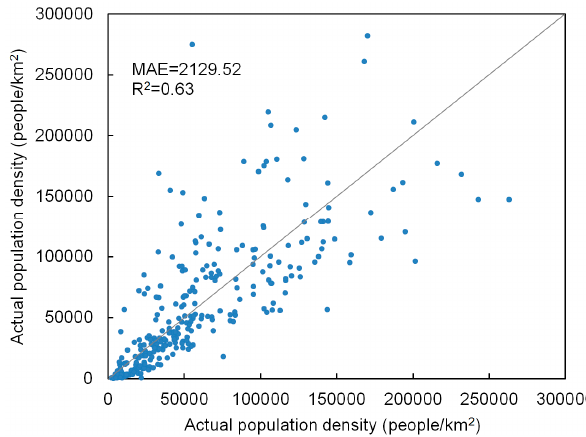
Figure 9. Scatterplot for the estimated population density from the random forest model and the actual population density from census data.